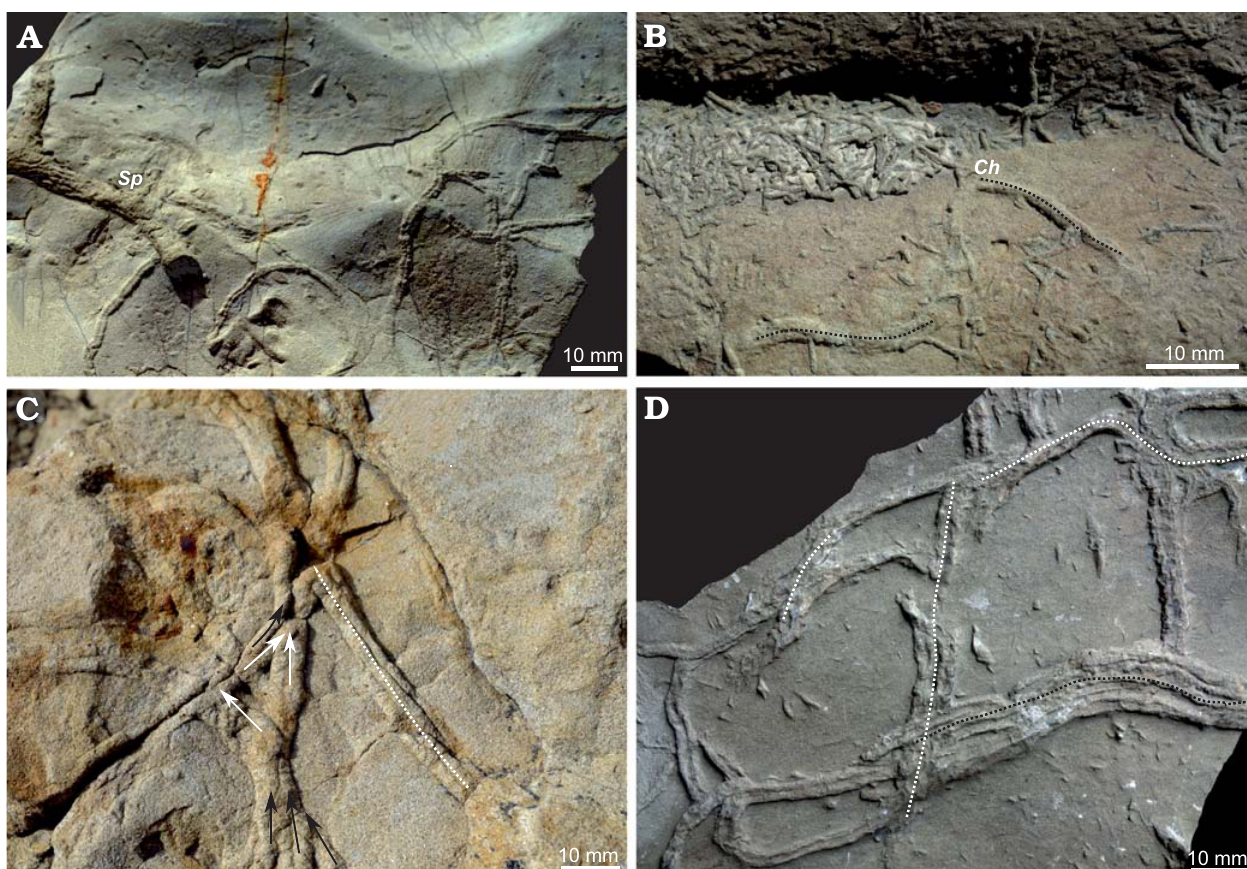
Fig. 8. Gyrochorte “highways” documenting a sequorichnial behaviour of the producers from different localities. A , B . Agrio Formation, Cretaceous, Neuquén Basin, Argentina. A . Bed surface showing interference ripples cross-cut by Spongeliomorpha ichsp. ( Sp ). B . Ripple-trough fill reworked by Chondrites ichsp. ( Ch ) producers (black doted lines). C . Lajas Formation, Upper Jurassic, Neuquén Basin, Argentina; converging (black arrows), diverging (white arrows), and overlapping Gyrochorte ichsp. (white doted line). D . Middle Jurassic, Helvetic realm, exact location not recorded, Switzerland (NMB O157) showing parallel Gyrochorte ichsp., 2 parallel traces (white doted line between them), 3 parallel traces (black doted line between them). Specimens A–C left in the